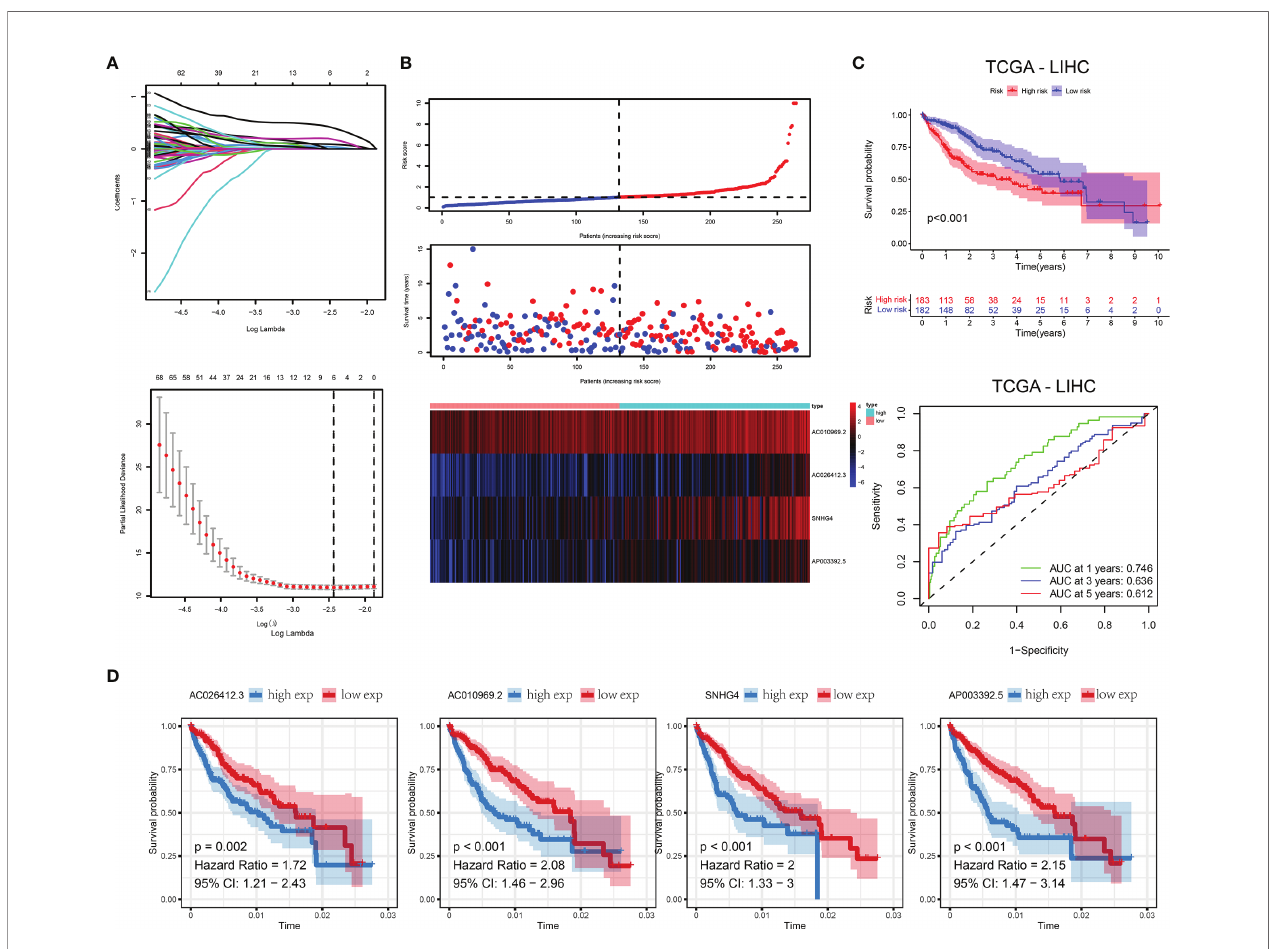
FIGURE 4 | (A) Trajectories for each independent variable and con fi dence intervals for different values. (B) Distribution of RiskScore and survival status of 4-gene signature. (C) In the training set, the survival curve of the four-gene signature and the ROC curves of 1, 3, and 5 years. (D) Kaplan-Meier survival curves of four